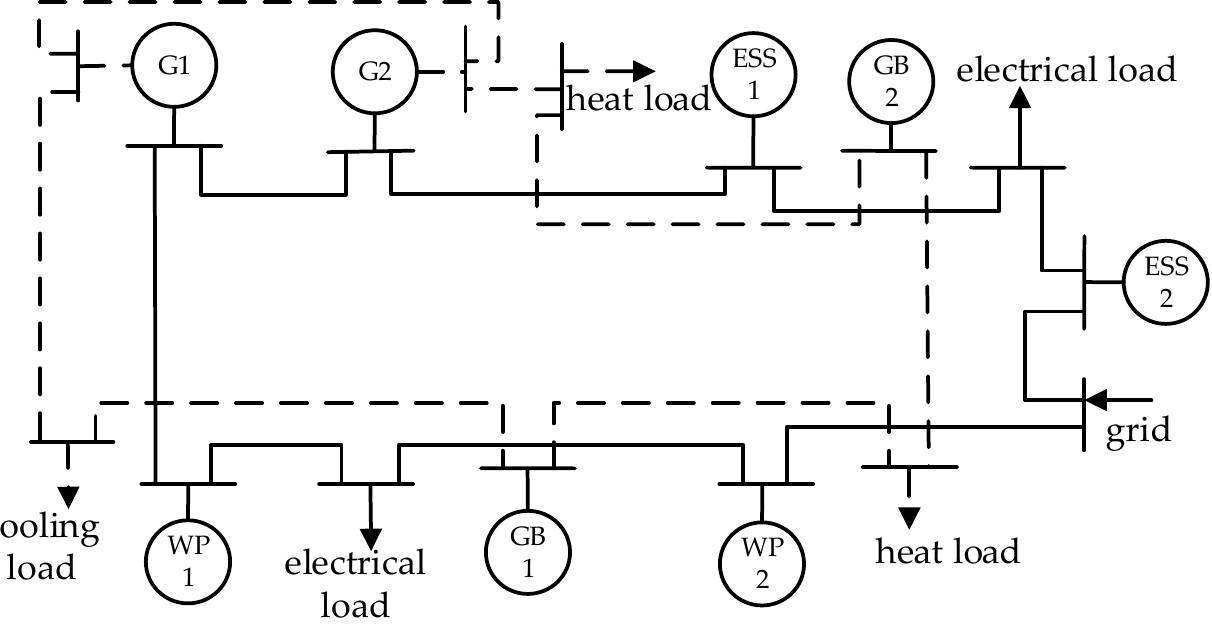
Figure 3. C RIES architecture. Figure 3. CRIES